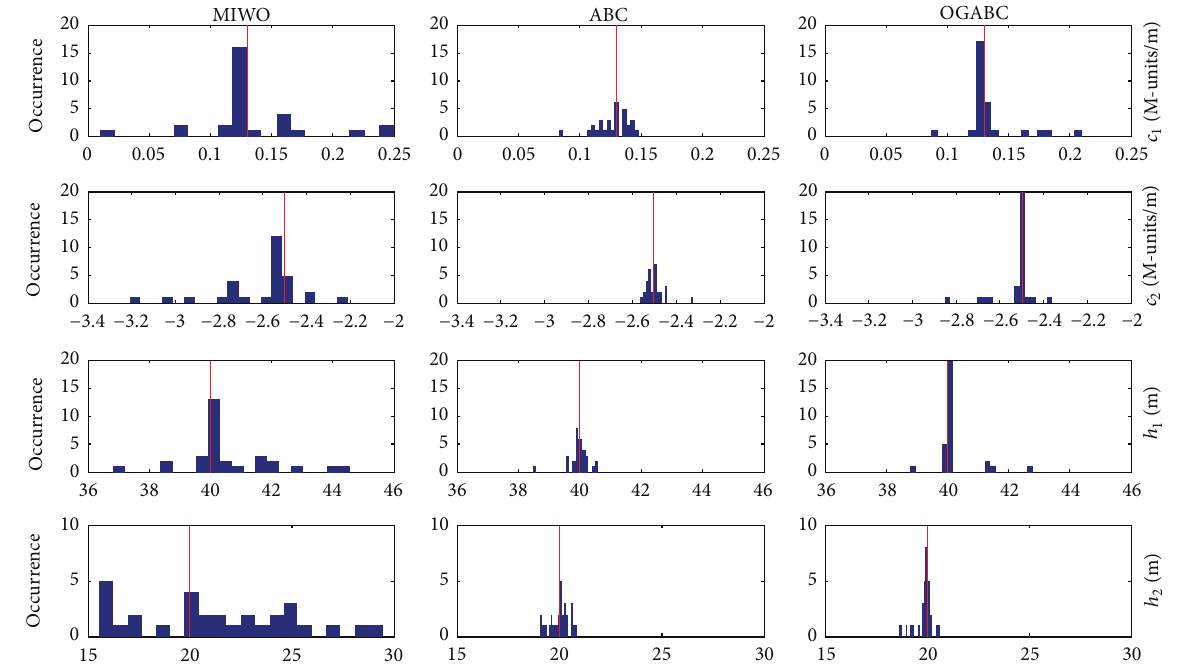
Figure 5: The comparison of the histograms of the inversion results for different algorithms with the noise level of 3dB.